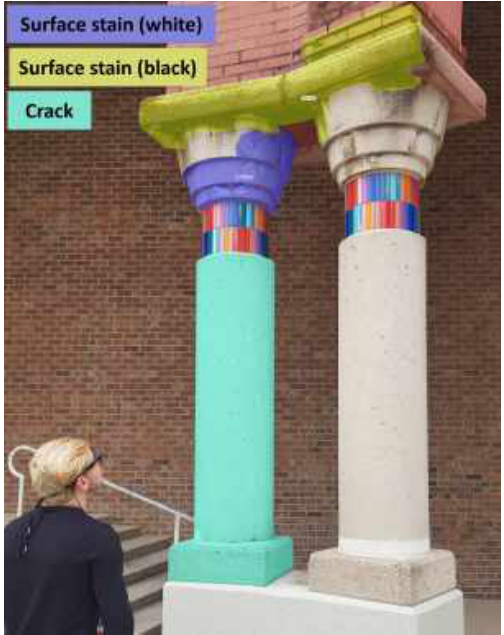
Figure 5. AOI labeling on visual stimuli for damage